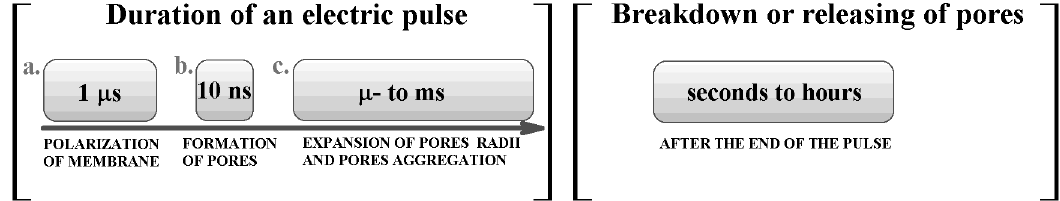
Figure 2. Time-course of a typical PEF experiment after releasing pulses on a generic eukaryote vegetable cells.